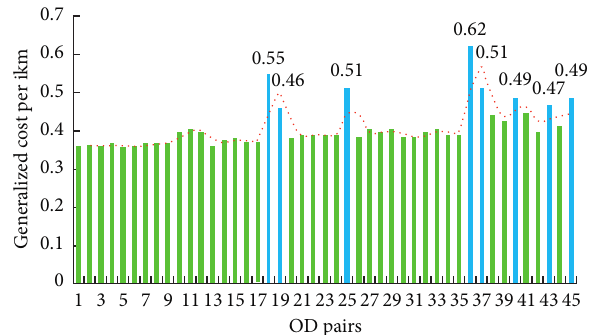
Figure 18: Generalized cost per kilometer for each OD